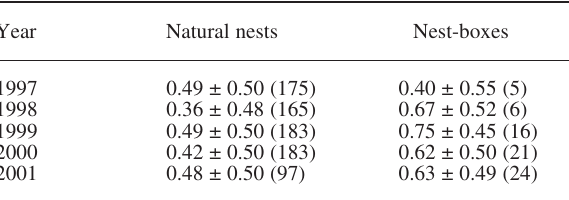
T ABLE 2. – Annual nesting success in natural nests and nest-boxes (i.e. proportion of chicks fledged over eggs laid; mean ± SD, n).